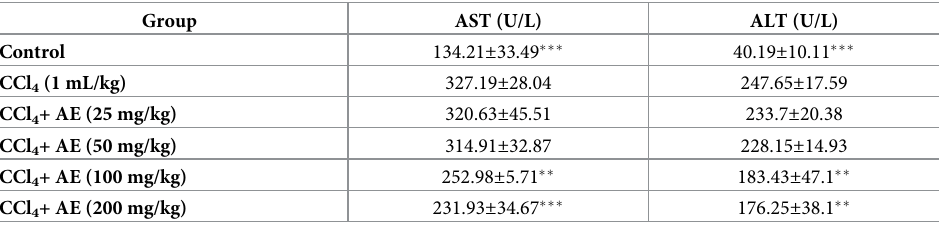
Table 5. Effect of P . niruri AE different doses on AST and ALT levels after rat acute CCl 4 intoxication. Group